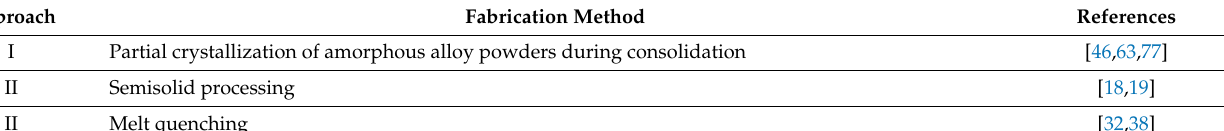
Figure 5. Approaches to the design of metallic glass (amorphous alloy)-reinforced MMCs. Table 3. Fabrication methods of metallic glass (amorphous alloy)-reinforced MMCs.